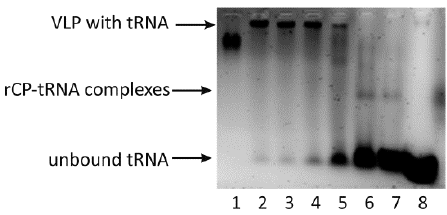
Figure 2. BMV-based VLPs formation according to various CP/tRNA mass ratios in native agarose gel electrophoresis. Lanes: 1—wt BMV, 2–7—various CP/tRNA mass ratios (from 6:1 to 1:1), 8—tRNA without CP. The arrows indicate formed VLP with tRNA inside, intermediate CP-tRNA complexes and the unbound tRNA.